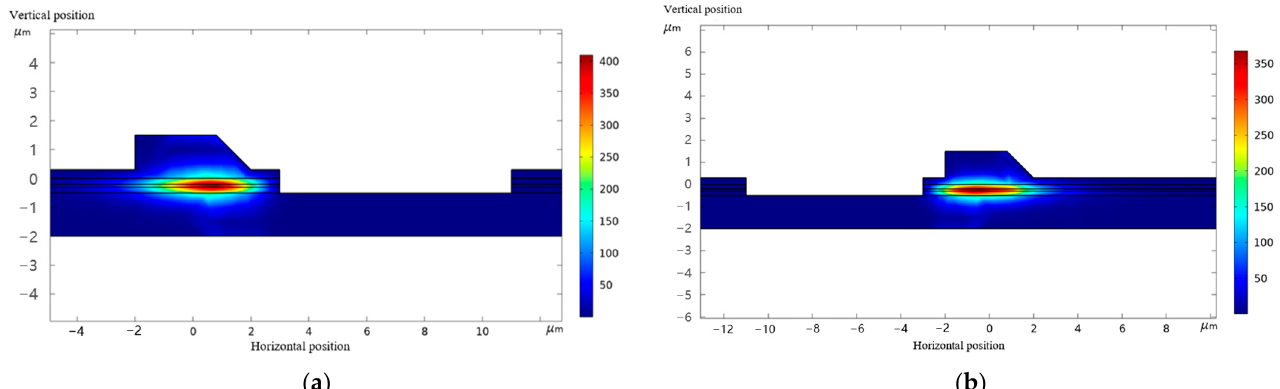
Figure 4. Diagram of the calculated mode distribution ( a ) the right trench structure; ( b )the left trench